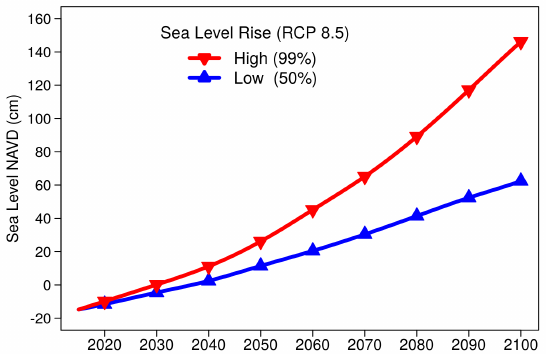
Figure 2. South Florida sea level rise projection with respect to 2015 mean sea level in Florida Bay for the RCP 8.5 greenhouse gas emission scenario. Units are cm NAVD88. Low projection is the median (50th percentile); high projection the 99th percentile. Tides and storm surges are not included in this projection. Values are tabulated in Appendix B to year